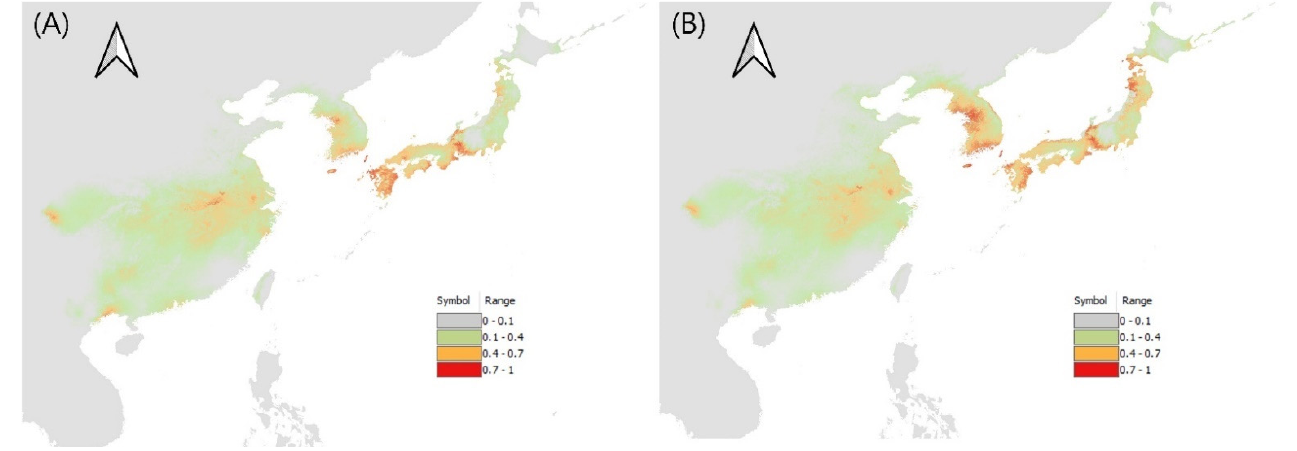
Figure 2. Potential distribution of L. chinensis ( A ) under current climate, and ( B ) for 2081–2100. The potential distribution map of L. acuta showed high values mainly in subequatorial and subtropical regions, including Southeast Asia and Oceania, corroborating previous records [15,37]. In this model, the precipitation of the warmest quarter had the highest contribution, followed by the minimum temperature of the coldest month, land cover, elevation, and isothermality, whereas mean diurnal range, the precipitation of the driest quarter, the maximum temperature of the warmest month, the mean temperature of the wettest quarter, and the precipitation of the coldest quarter contributed little. As a result of applying the SSP245 climate change scenario, L. acuta , which has the widest distribution among the Leptocorisa species, was predicted to have a similar distribution range to the current climate (Figure 3, Supplementary Figures S6 and S7).